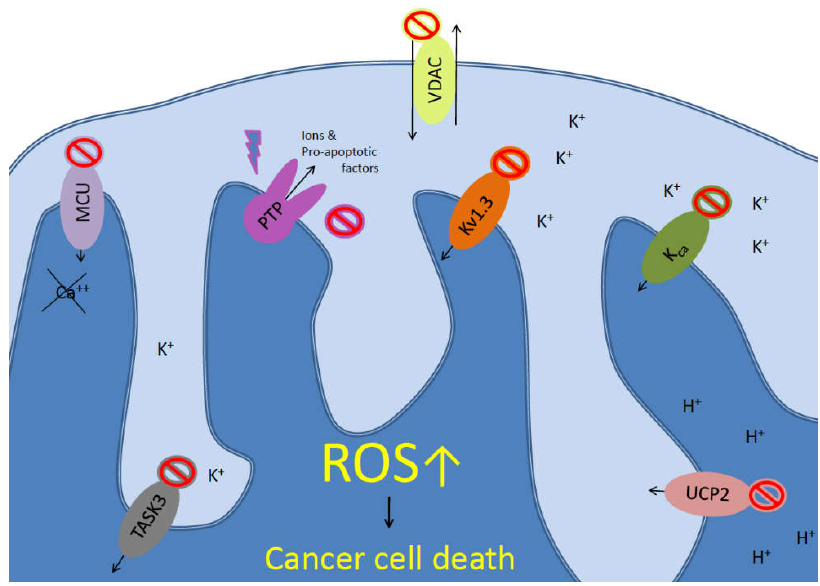
Figure 1. Mitochondrial ion channels involved in cancer. Mitochondrial physiology counteracts reactive oxygen species (ROS) accumulation, protecting cancer cells by ROS mediated cell death. voltage‐gated potassium channels 1.3 (Kv1.3), Ca 2+ ‐dependent channels of the inner mitochondrial membrane (KCa), TWIK‐related acid‐sensitive K channel‐3 (TASK3), voltage‐dependent anion channel (VDAC), uncoupling protein‐2 (UCP2), mitochondrial permeability transition pore (mPTP), and mitochondrial calcium uniporter (MCU) complex directly or indirectly modulate ion homeostasis (in the directions indicated by the arrows), transmembrane potential, ROS production, and mitochondrial